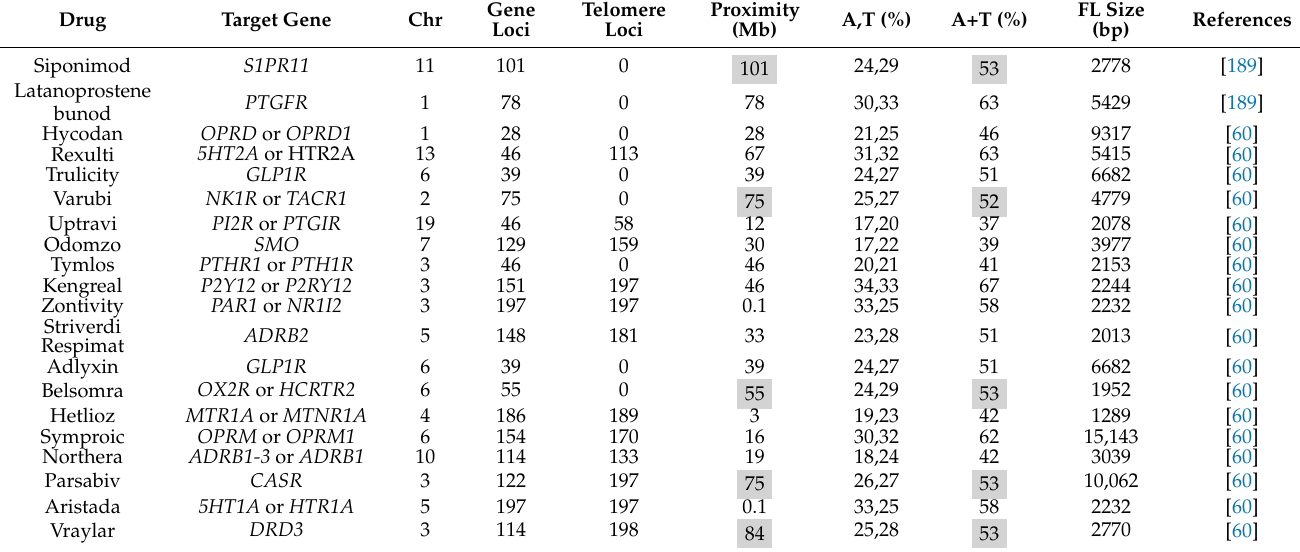
Table 2. Two factor characteristics of 20 GPCRs targeted by approved